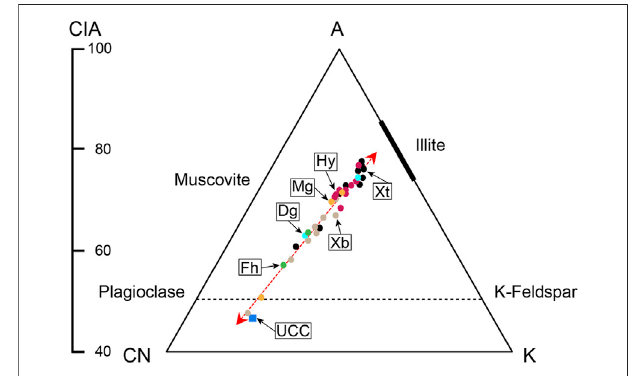
FIGURE 4 | The proportion of Al 2 O 3 – (CaO* + Na 2 O) – K 2 OA-CN-K) ternary plot and CIA index for the sand samples (after Nesbitt and Young, 1982 and Fedo et al.,